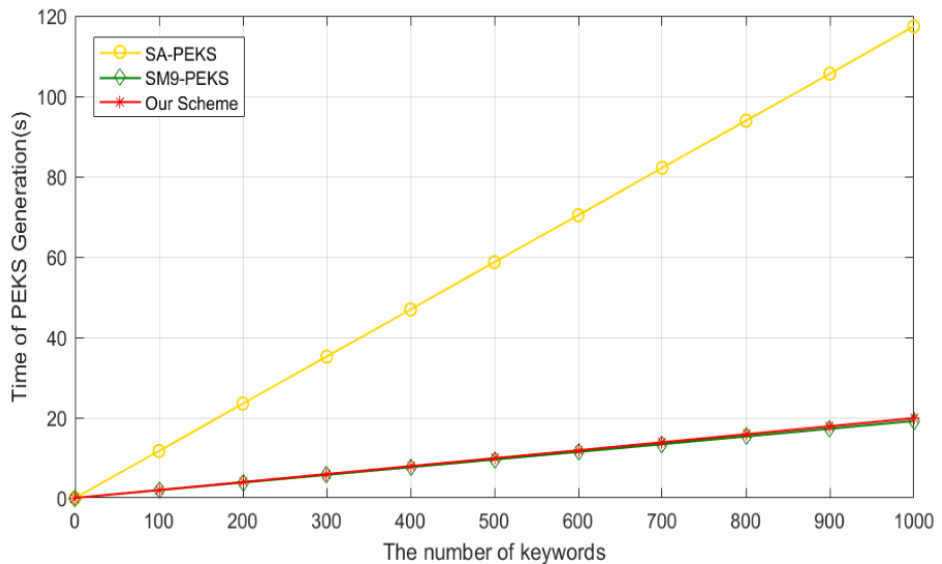
Figure 4. Computation cost of PEKS Ciphertext generation.